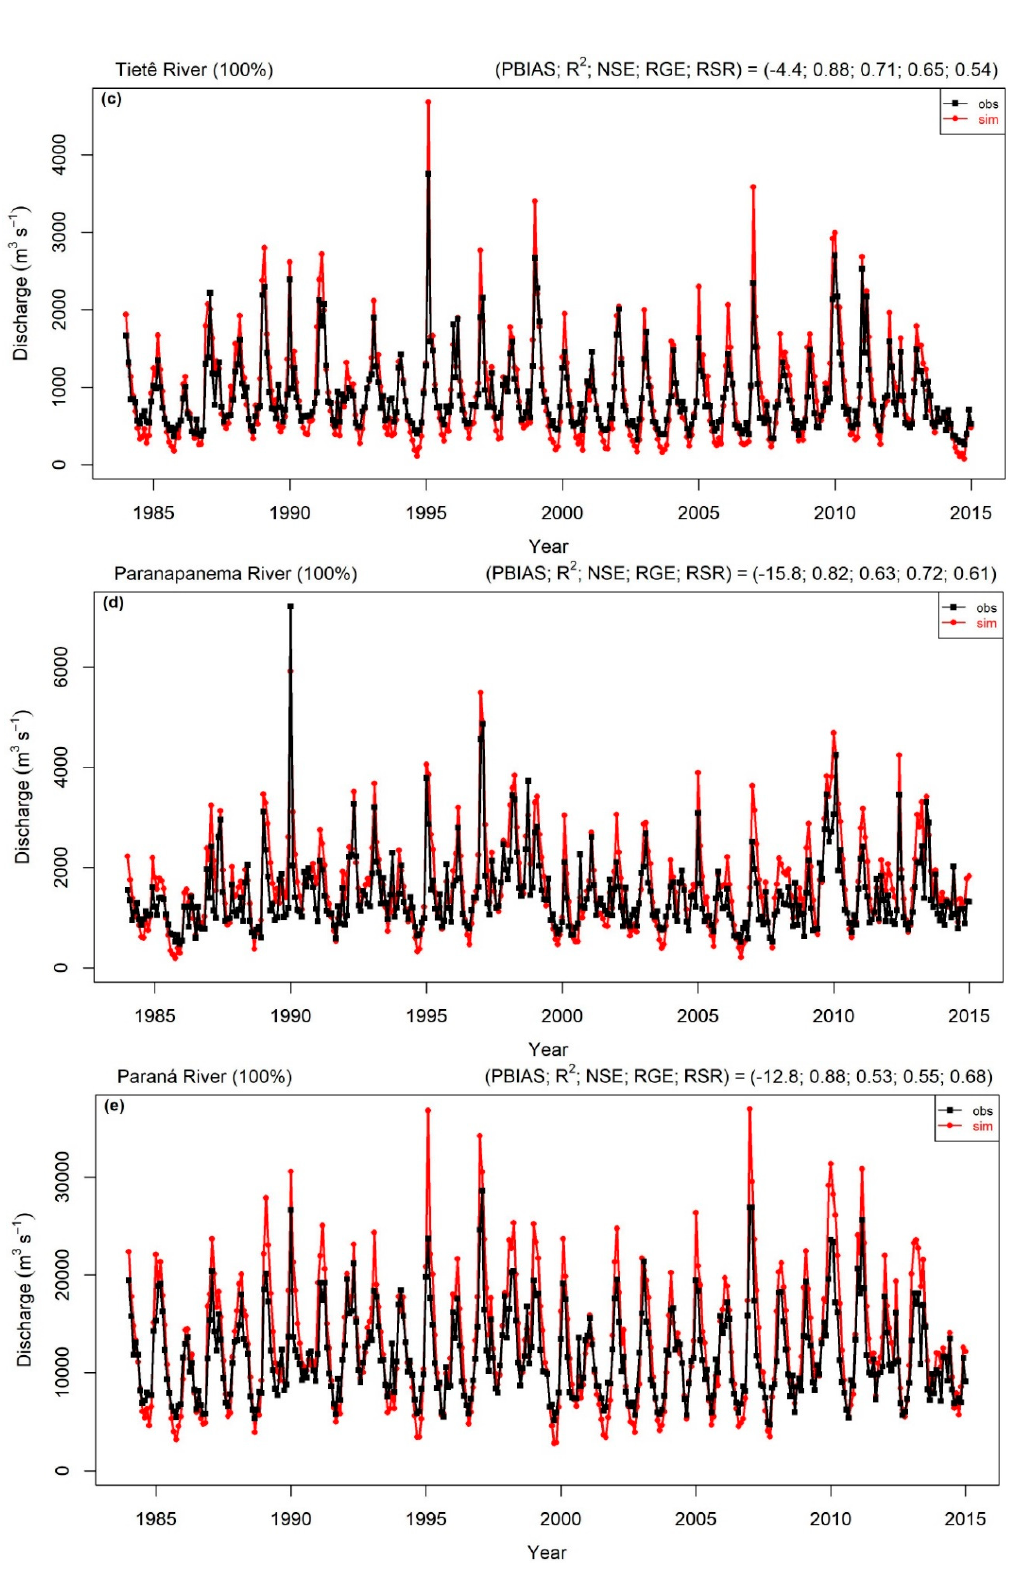
Figure 6. Temporal evolution of the monthly discharge and their statistical indices values from the last outlet of the main rivers of the UPRB. ( a ) Paranaíba; ( b ) Grande; ( c ) Tietê; ( d ) Paraná; and ( e ) Paranapanema.